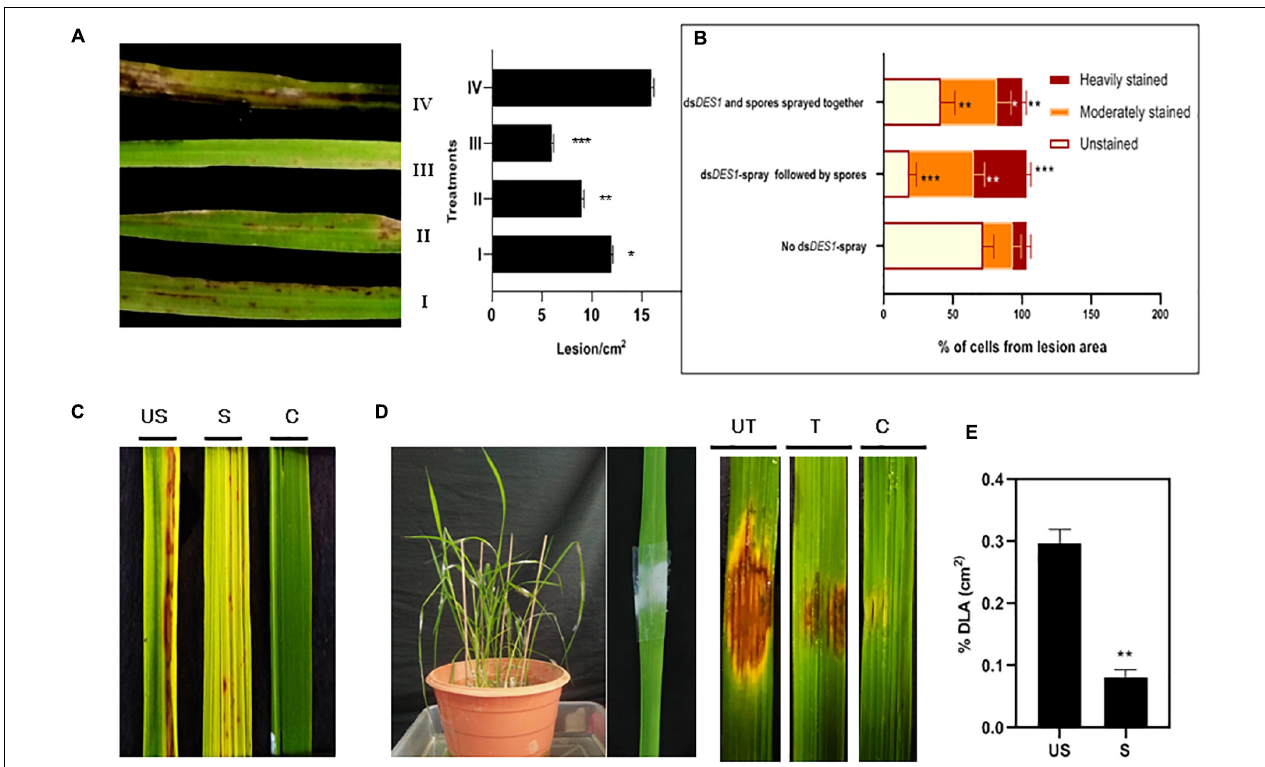
FIGURE 6 | In vivo infection assay of ds DES1 -sprayed plants. (A) The left panel shows spray-infected rice leaves that were sandpaper-abraded (to reduce the mechanical barrier) and sprayed with 300 nM ds DES1 (III) 24 h prior, (II) 12 h prior, or (I) 0 h prior (spores and ds DES1 were mixed together before spraying) to fungal inoculation. The unsprayed but fungus-inoculated set (IV) was used as control. The right panel indicates the relative infection severity for each treatment based on lesions/cm 2 . (B) DAB staining of lesions isolated from treatment sets I, III, and IV, representative of counter-infection host-derived ROS generation assay. The level of ROS generation was color-coded, and the fraction of cells representing each color was categorized. (C) Spray infection assay of ds DES1 -sprayed (S) and unsprayed (US) leaves. Leaves that were neither dsRNA-sprayed nor spore-inoculated, were used as control (C) . (D) Punch inoculation-mediated infection assay for ds DES1 drop-treated (24 h prior) rice leaves. Leaves that were simply punched and inoculated with Tween 20-Gelatin mixture without spores or ds DES1 were kept as control. (E) Disease severity in ds DES1 -sprayed and unsprayed leaves expressed in terms of% diseased leaf Area (DLA). For infection related experiments, observations were performed on at least 50 leaves, and% DLA was assessed using the Image J software. Error bars represent standard deviation ( n = 50); where *, **, and *** denote statistical significance (Student’s t -test) at the P ≤ 0.05, P ≤ 0.01, and P ≤ 0.001 levels,